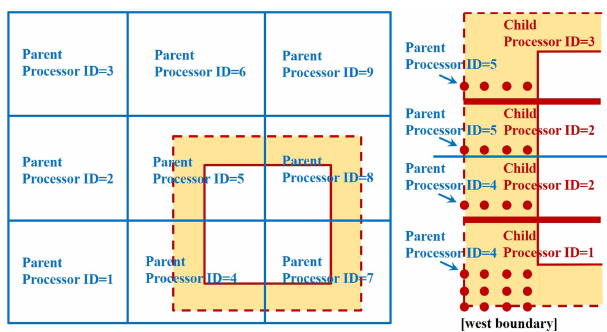
Figure 3. Decomposed domain by MPI and the relation between the parent processor ID and child processor